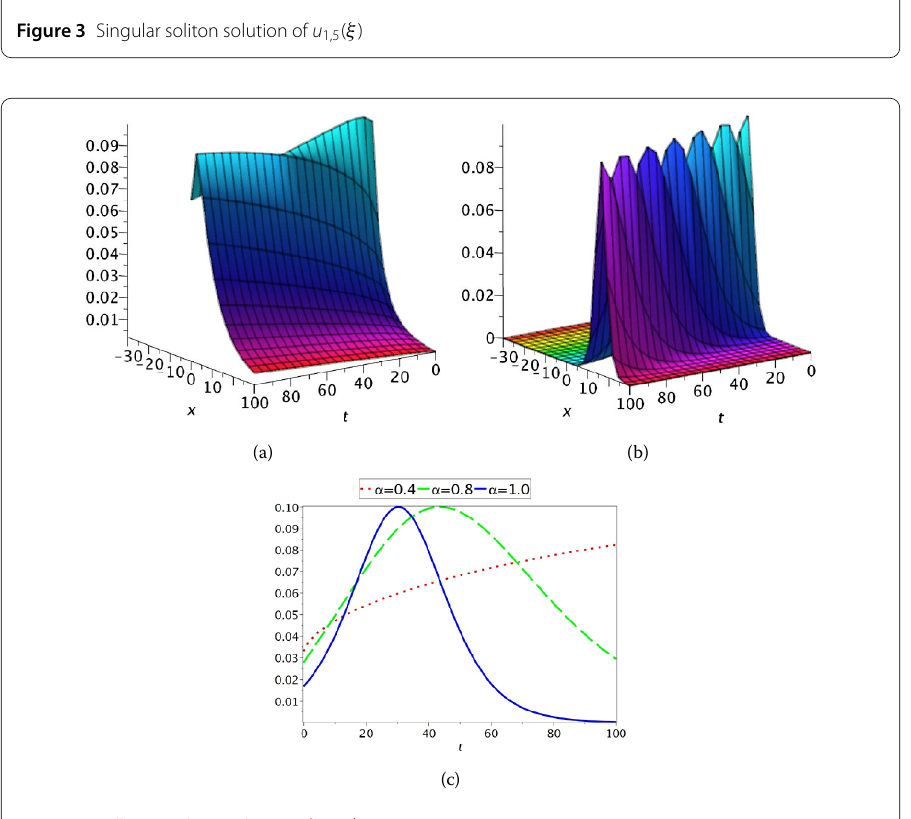
Figure 4 Bell type soliton solution of u 1,6 ( ξ